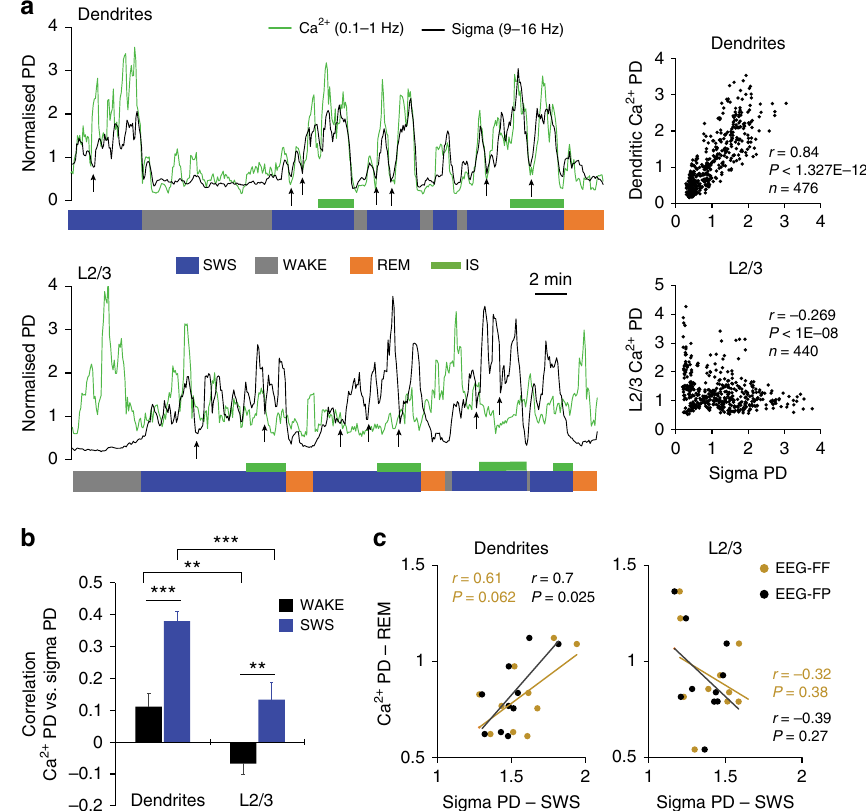
Fig. 3 Correlation between Ca 2+ activity in population of dendrites and sigma EEG power. a Example of Ca 2+ and sigma PD fl uctuations for an ~30 min recording segment from dendrites ( upper graph ) and L2/3 neurons ( lower graph ). Data are represented as trendlines (see Methods) and arrows point at microarousals ( < 5 epochs). Corresponding scatter plots are on the right ( n = number of epochs, r = Pearson ’ s correlation coef fi cient). b Mean ( ± s.e.m.) correlation between sigma and Ca 2+ activity in dendrites and L2/3 neurons across animals ( n = 11/group) for WAKE (AW and QW) and SWS. Correlation with FF and FP EEGs were pooled due to similar trend (two-way ANOVA; factor “ EEG ” : F 1,122 = 0.06, P = 0.801; “ Group ” : F 1,122 = 33.26, P < 0.001). Within groups, the correlation was higher during SWS compared to wakefulness (two-way ANOVA; factor “ state ” : F 2,120 = 22.97, P < 0.001, ** P < 0.01 and *** P < 0.001, Holm – Sidak test). c Correlation (Pearson) between sigma PD during SWS and Ca 2+ PD in dendrites and L2/3 neurons during REM sleep. Values represent the average Ca 2+ and EEG (FF and FP) PDs for each animal. Values from individual 4 s epochs were used for all